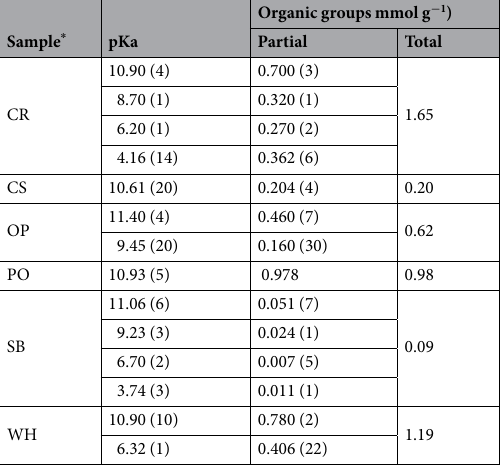
Table 3. Analyses of pKa and the amounts of organic groups present in the biochar samples, measured at 25 °C in 0.10 mol L − 1 KCl. The values in parentheses are the variations of the measurements (last decimal place). * CR = charcoal fines; CS = coconut shell; OP = orange peel; PO = palm oil bunch; SB = sugarcane bagasse; WH = water hyacinth.